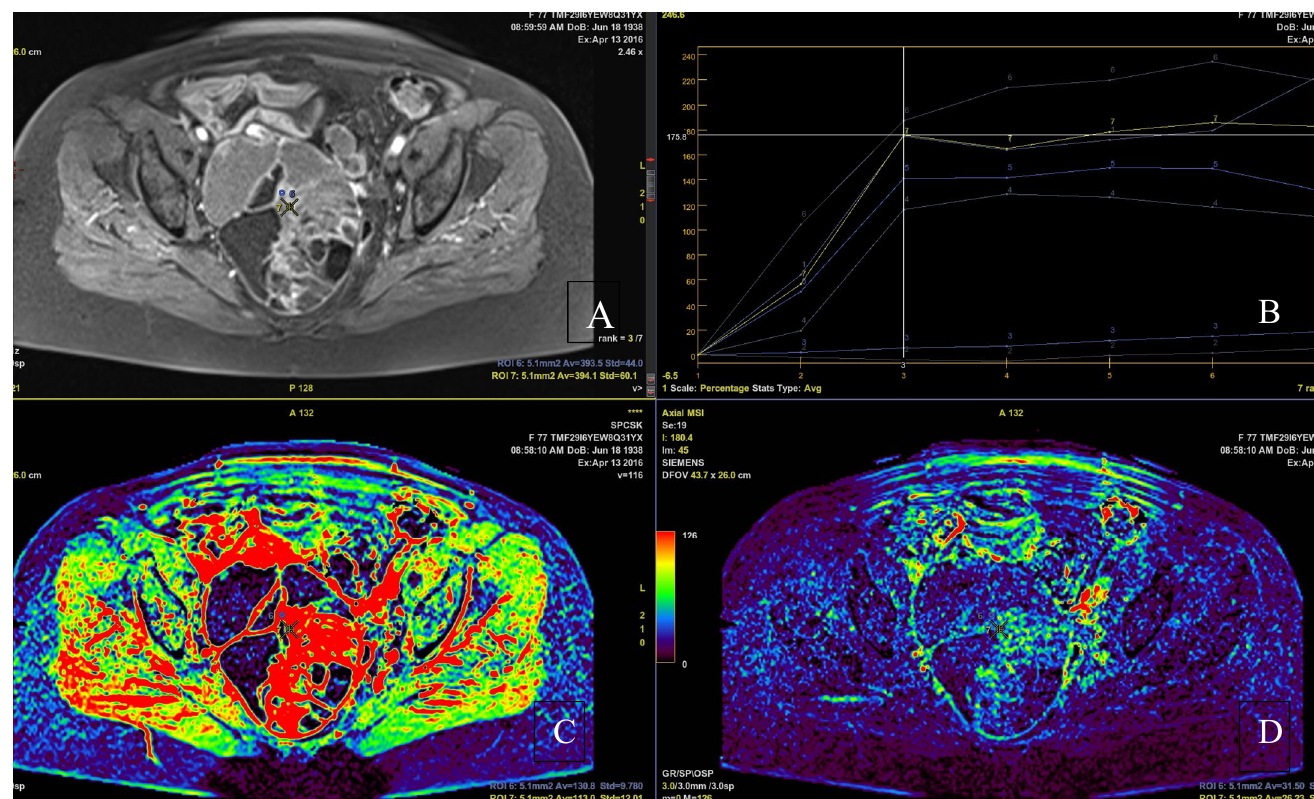
Figure 2. Images from the same 77 year-old women with low-grade serous ovarian cancer. ( A , C , D ) Dynamic contrast enhancement. ( B ) Contrast enhancement curves.